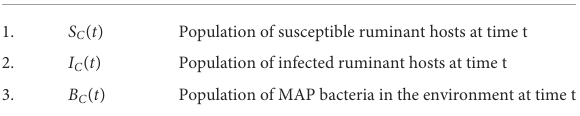
TABLE 1 A summary of the variables associated with the transmission cycle of PTB at the between-host scale.